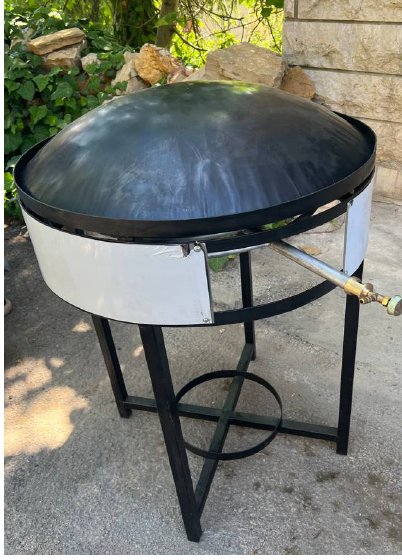
Figure 7 . A domestic saj . Figure 7. A domestic saj